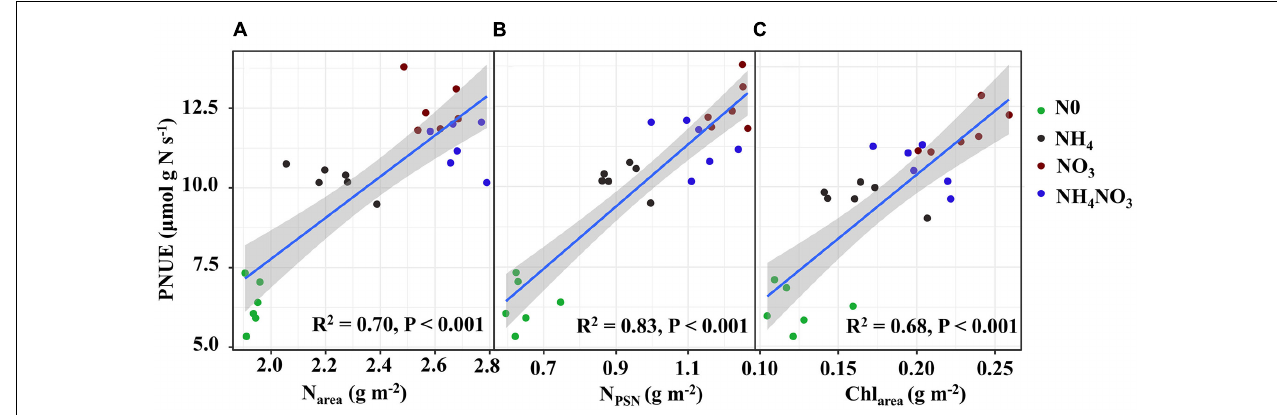
FIGURE 6 | Relationships of photosynthetic N use efficiency (PNUE) with area-based N content (N area ) (A) , photosynthetic N (N PSN ) (B) and area-based chlorophyll content (Chl area ) (C) in L. chinensis . The color of green, black, red, and blue correspond to the N0, NH 4 , NO 3 , and NH 4 NO 3 treatments. Relationships between variables were assessed using linear regression analysis.